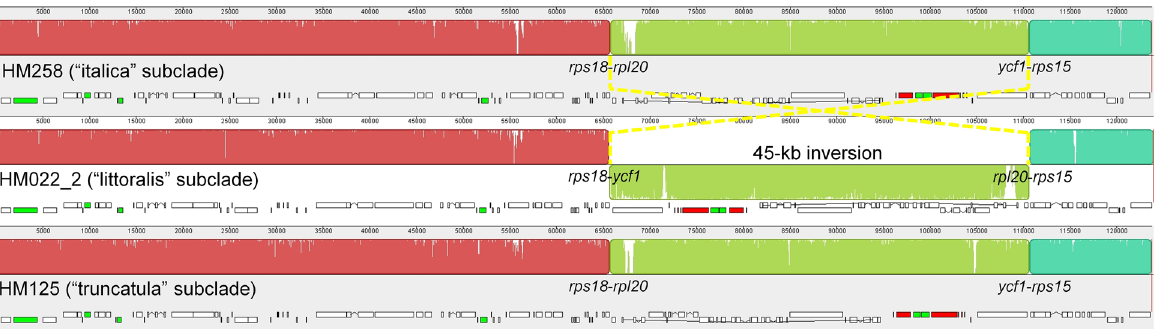
Figure 4. Mauve alignment of representative plastomes of the three subclades of the TLI clade. Alignment coordinates are given in bp above each sequence. Each locally collinear block (LCB) is differently colored, and histograms within it represent pairwise sequence identity. The inverted 45-kb LCB in the “littoralis” subclade is shown as a flipped block across the